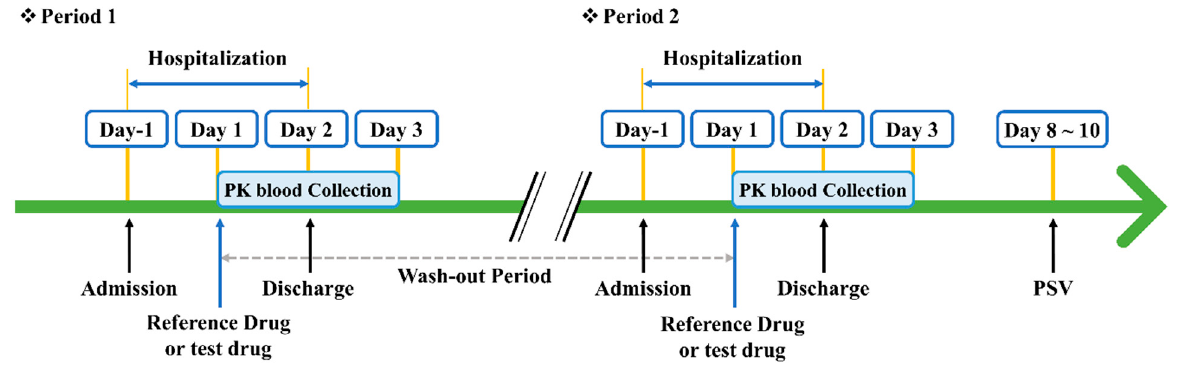
Figure 4. Schematic of the simple two-way crossover design trial.